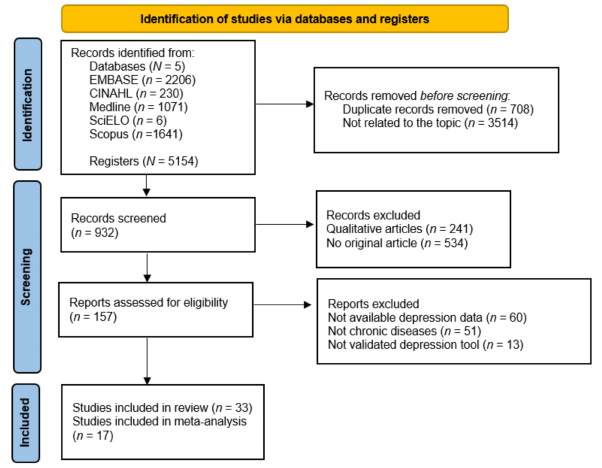
Figure 1. Flow diagram of the publication search